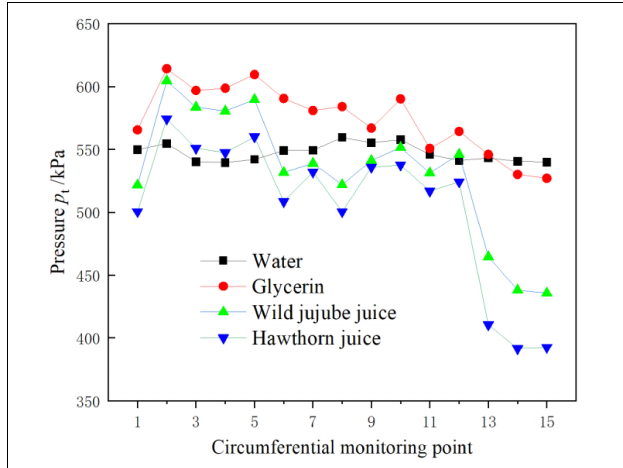
FIGURE 9 | Total pressure on volute casing of the centrifugal pump with different viscosity.